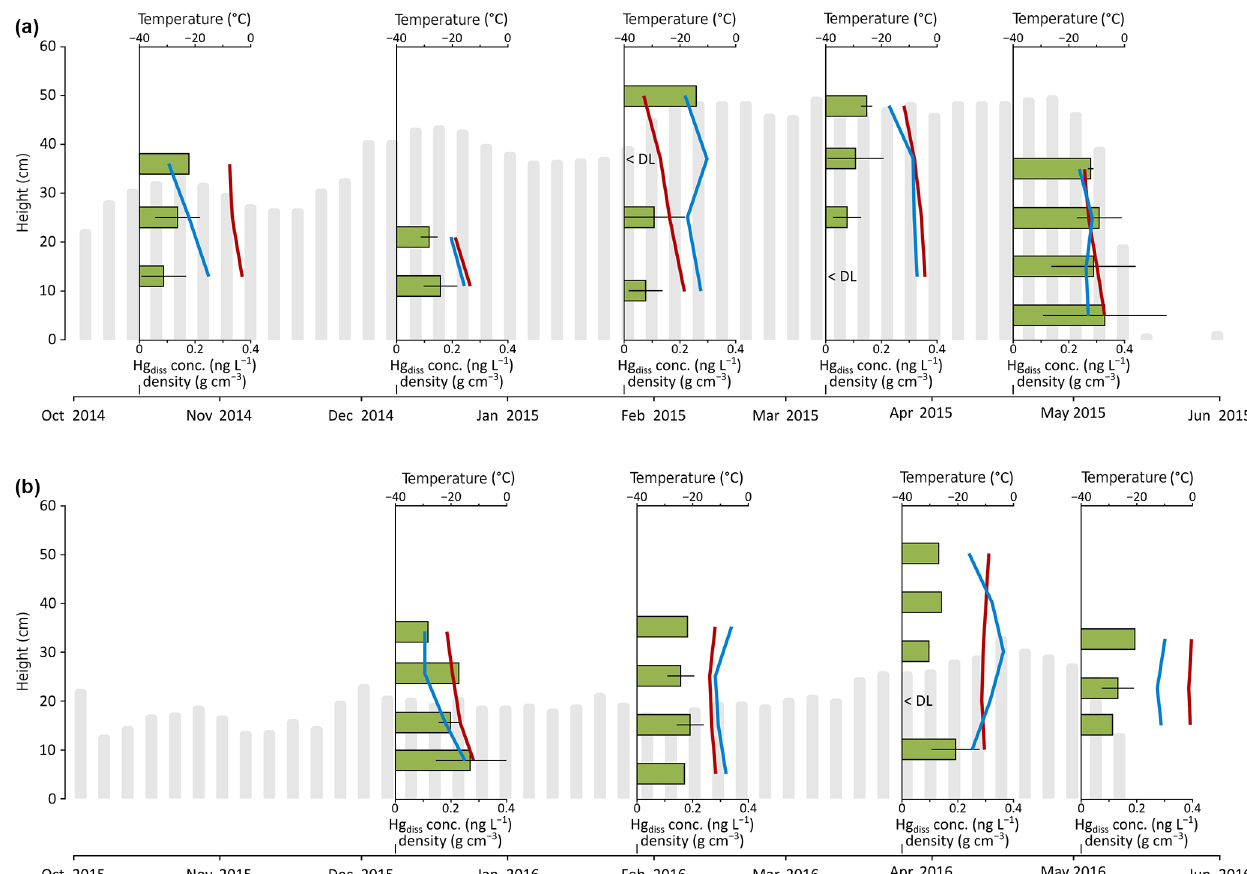
Figure 2. Snowpack temperatures (red lines) and densities (blue lines) and dissolved Hg concentrations (green bars, including mean values and standard deviations) for five snow pits in the 2014–2015 season (a) and four snow pits in the 2015–2016 season (b) over the Arctic tundra at Toolik Field Station. The gray bars illustrate the average snow